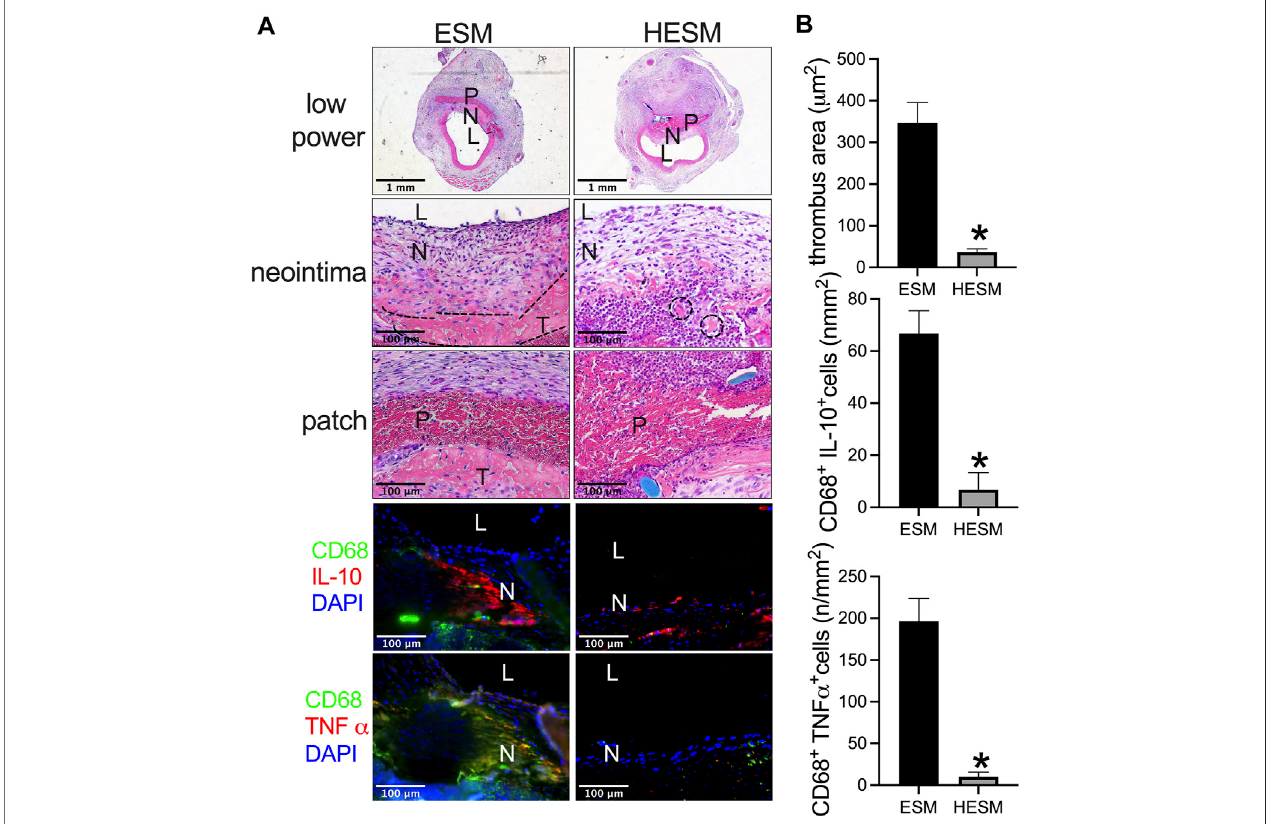
FIGURE 6 | Heparin-coated ESM (HESM) decreases mural thrombus formation and macrophage in fi ltration after rat aortic patch angioplasty at day 14. (A) Photographs of hematoxylin & eosin (H&E) staining of the ESM and HESM patches after angioplasty at day 14, scale bar, 1 mm or 100 μ m; L, lumen; P, patch; N, neointima; T, thrombus; dashed line area shows the demarcation of the thrombus. Photograph of the immuno fl uorescence staining for IL-10 (red), CD68 (green), and DAPI(blue);CD68(green)andTNF- α (red)intheneointimaoftheESMandHESMpatchesharvestedatday14;scalebar,100 μ m;L,lumen;N,neointima; n =3. (B) Bargraphshowingthrombusarea(* p =0.0034, t -test),CD68andIL-10dual-positivecellnumbers(* p =0.0056, t -test),CD68andTNF- α dual-positivecellnumbers(* p = 0.0026, t -test) in the neointima of ESM and HESM patches harvested at day 14; n =